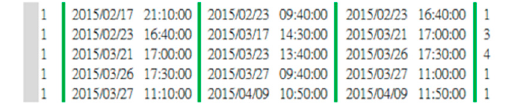
Figure 4. Example of data after the data aggregation step. Table 2. Event codes of failure messages in common use.